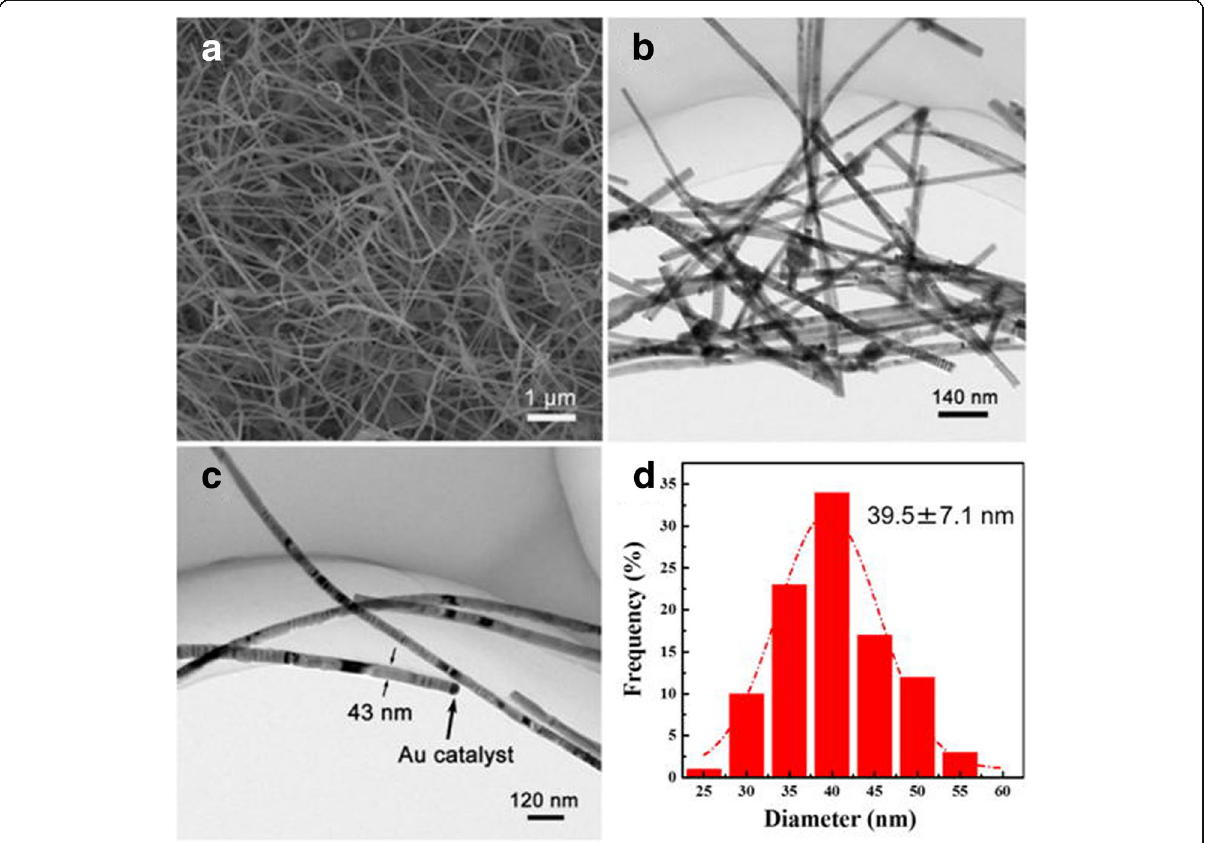
Fig. 2 a SEM image of the substrate surface after the reaction. b , c TEM bright-field images of InGaAs NWs. d Diameter distribution histogram of InGaAs